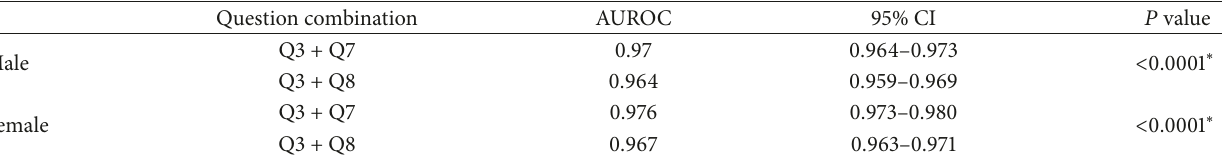
Table 2: Comparison of AUROCs between Q3 + Q7 and Q3 + Q8 in KNHANES